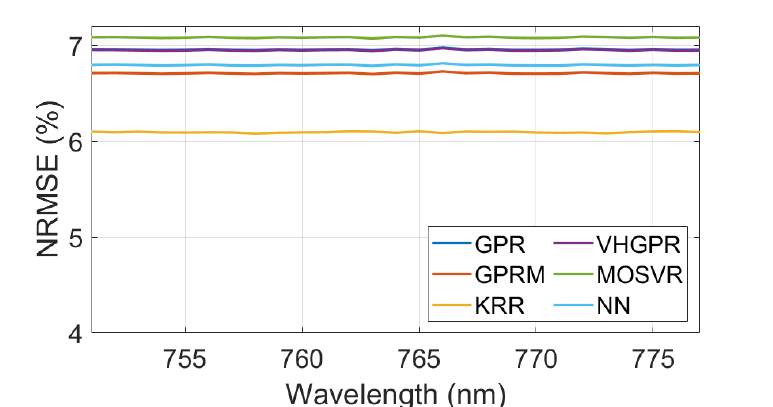
Figure 4. Spectral NRMSE (in %) results for the regression algorithms performance assessment as function of the five best regression algorithms, using (1000 samples, 20 PCA input, and 5 PCA output). Statistics obtained from the performance of the models used. RMSE is